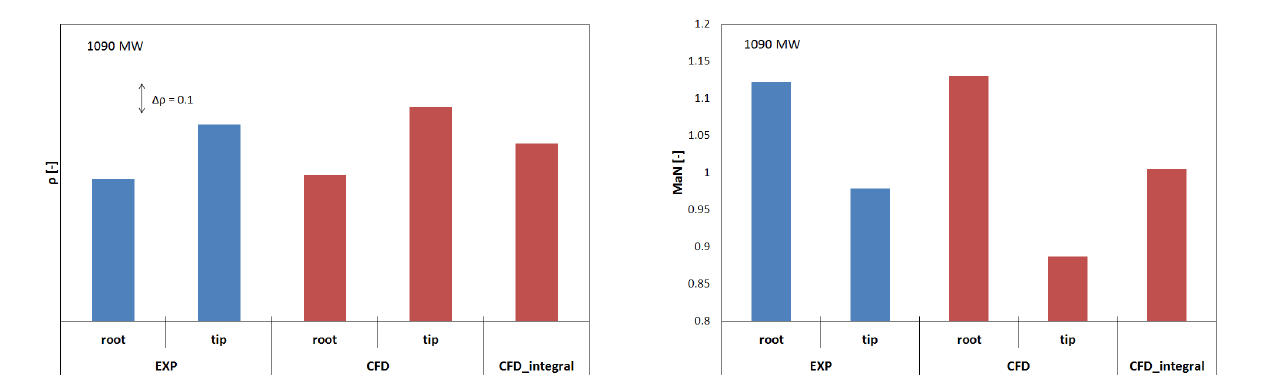
Figure 12. Stage reaction.